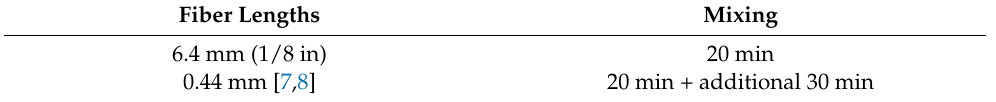
Table 3. Fiber lengths.